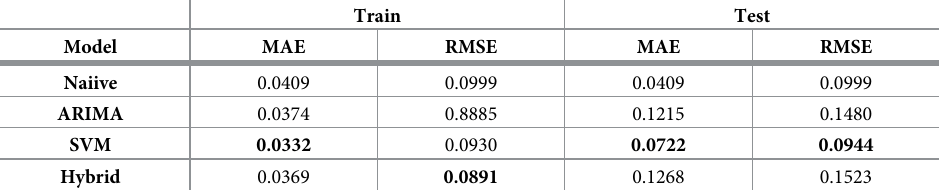
Table 3. Summary of MAE and RMSE values for train and test data set for the models developed as compared to benchmark